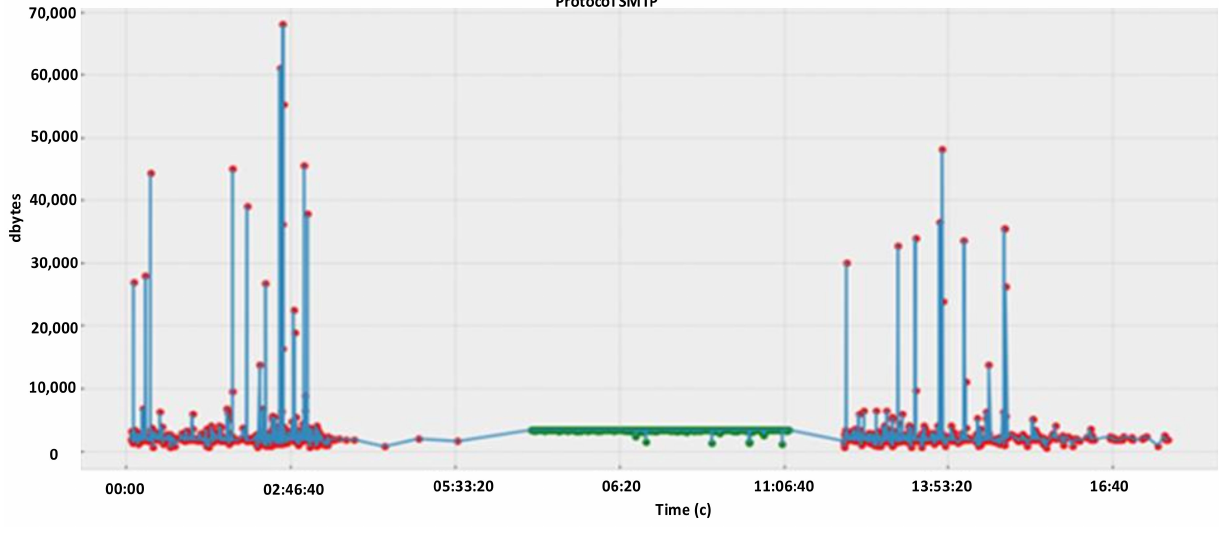
Figure 21. SMTP protocol.